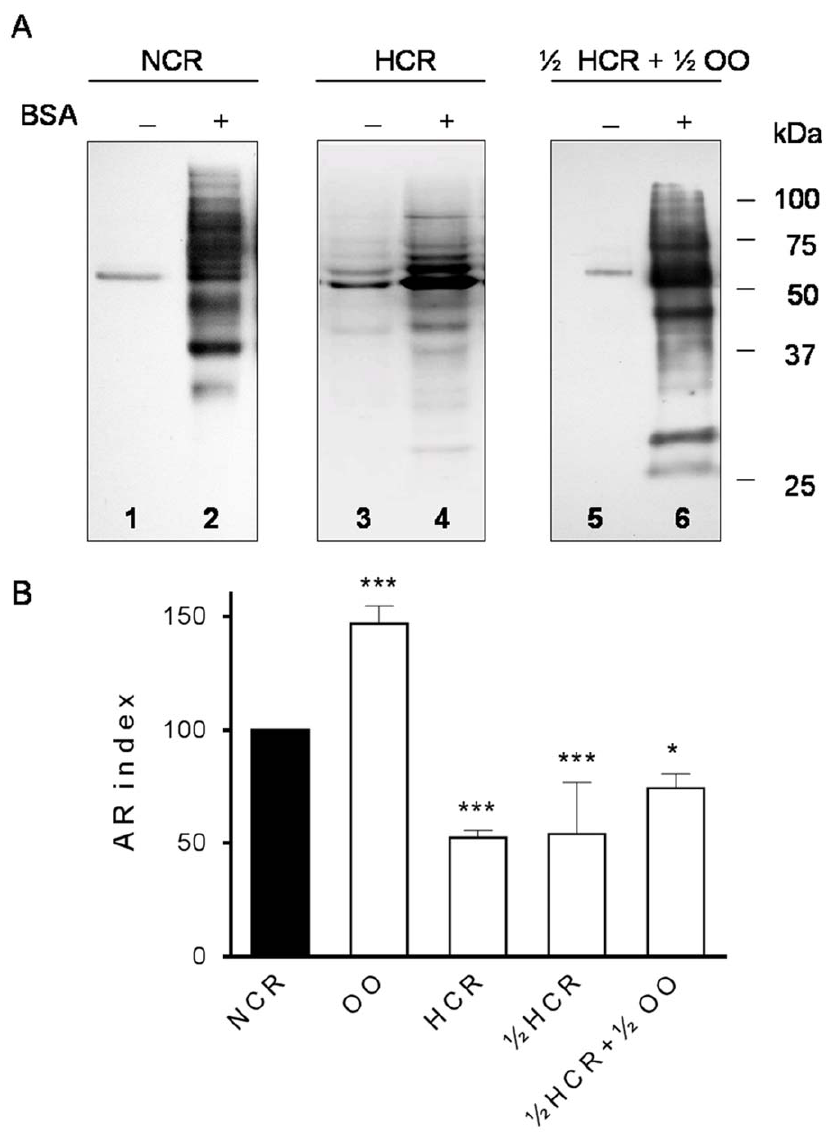
Figure 5. Impact of diet on sperm functionality: sperm capacitation and acrosome reaction. Protein tyrosine phosphorylation (A) and acrosomal exocytosis index (B) of rabbit spermatozoa. A: phospho-Y proteins from control (NCR), HCR and K HCR + K OO showed different patterns ranging from one band (non-capacitated, culture medium without BSA ( 2 ), approximately 60 kDa) to many bands (capacitated with BSA ( + ), from over 20 to 100 kDa). Notice that capacitated sperms from HCR decreased the p-Y protein pattern compared with NCR, and K HCR + K OO shows a p- Y pattern resembling control (NCR) conditions. The experiment was performed at least three times and representative blot is shown. B: Bars represent AR index of spermatozoa from NCR, K HCR, K HCR + K OO and OO after 10 m M progesterone incubation. AR index corresponds to normalized data (see Materials and Methods). n=25 samples. ***=significantly different from NCR (p , 0.001).